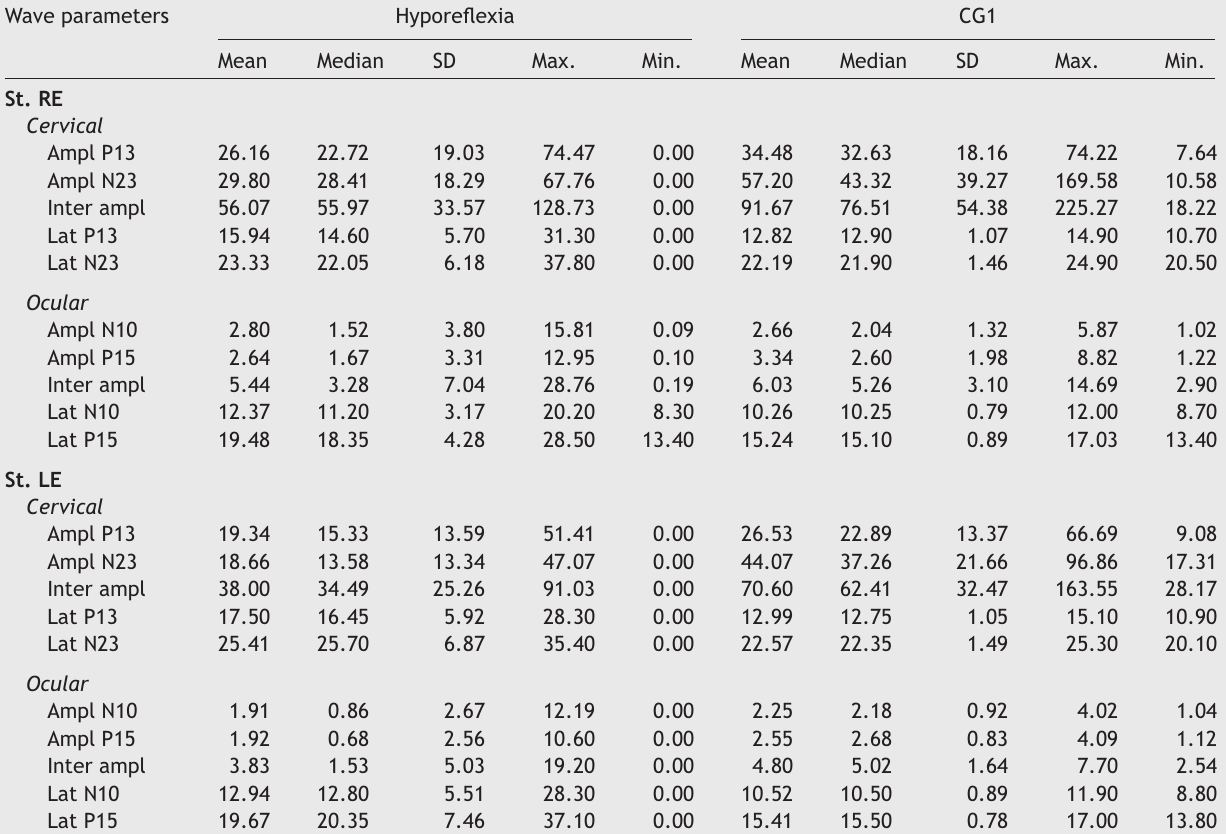
Measures of central tendency, dispersion, and position for latency (ms) and amplitude ( (cid:2) V) for combined cervical and ocular VEMP for individuals with vestibular hyporeflexia and individuals in the control group (CG1). Wave parameters